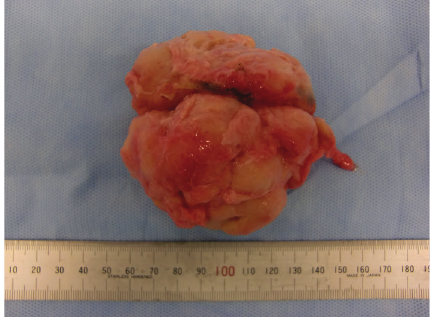
Figure 4: Enucleated adenoma weighing 159 g in Case